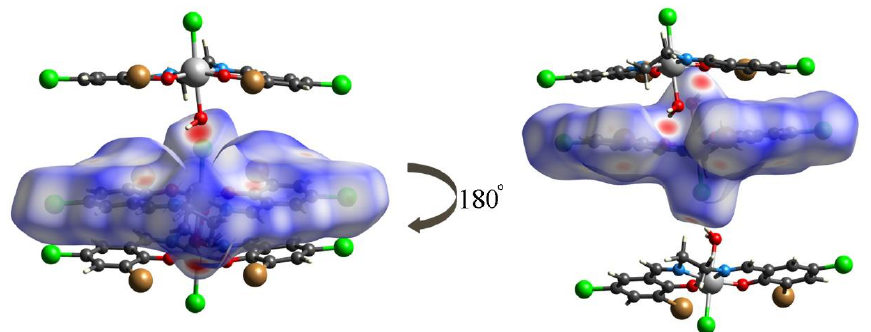
Figure 7. O – H···Cl interaction in 1 wherein the Hirshfeld surface emphasizes short intermolecular contacts.